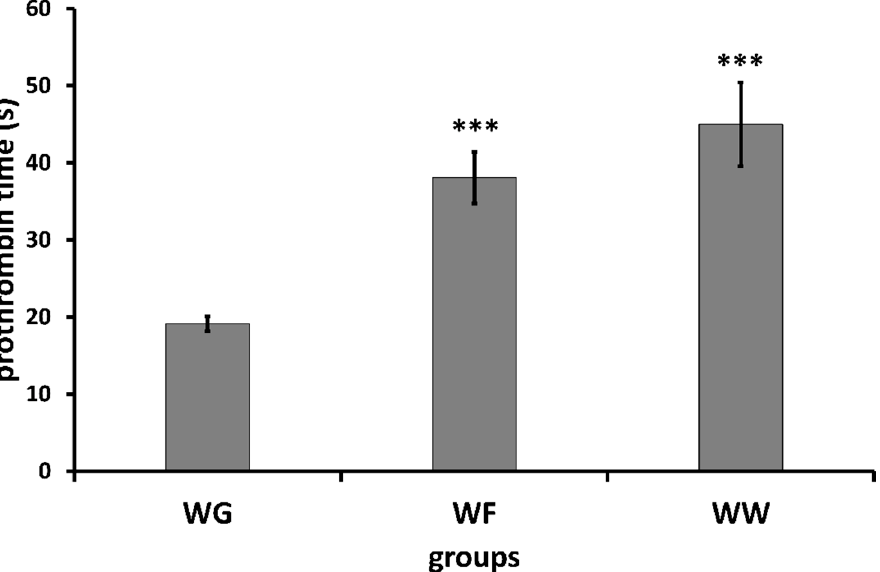
Figure 2. Mean ± SD of prothrombin time determined by means of optical coagulometer (WG: wheatgrass; WF: warfarin; WW: wheatgrass + warfarin). *** p < 0.01.